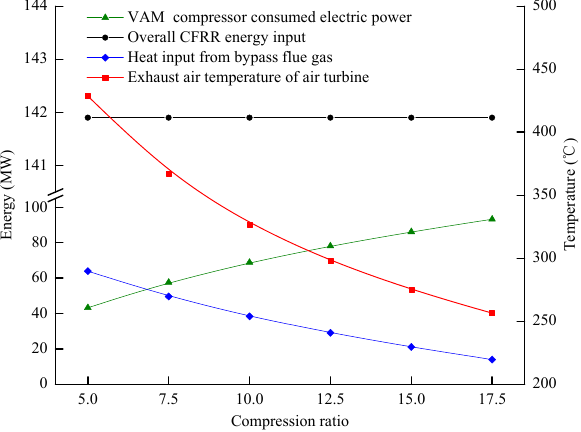
Figure 7. Influence of the compressed VAM pressure on the temperature of exhaust air and energy distribution within the VAM-based hot air power cycle.